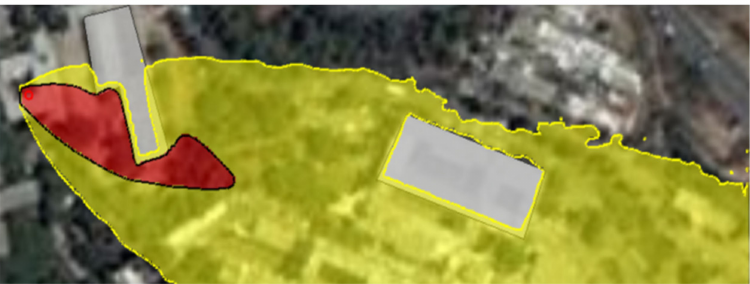
Figure 1. The Graz Lagrangian Model (GRAL) presents a ground truth simulation of gas dispersion with buildings. In red and yellow are the low-density and high-density gas areas.